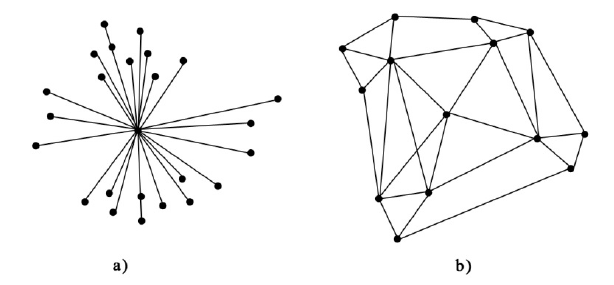
Figure 2. Architectural comparison of traditional (a) and blockchain (b)